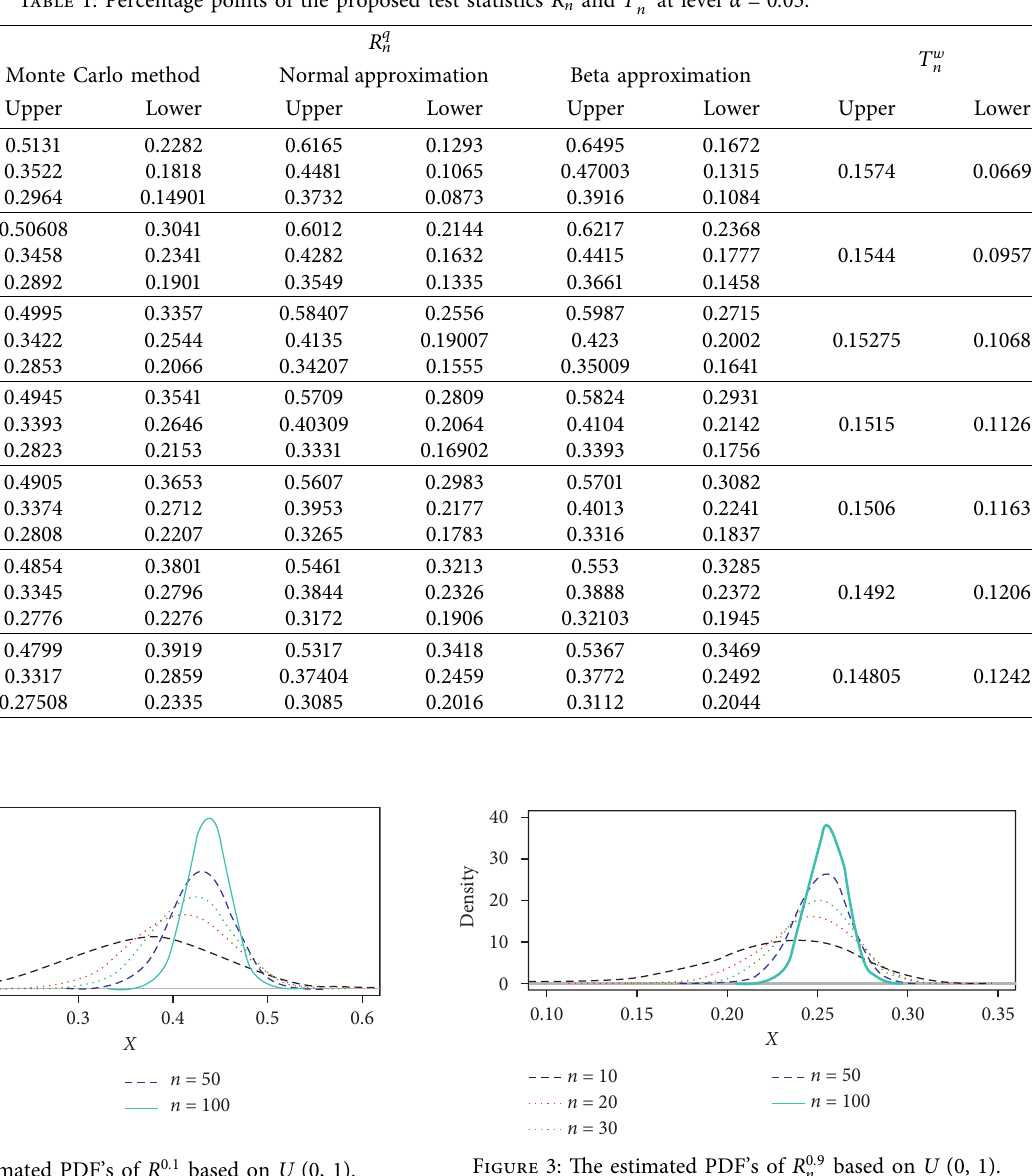
Table 1: Percentage points of the proposed test statistics R q